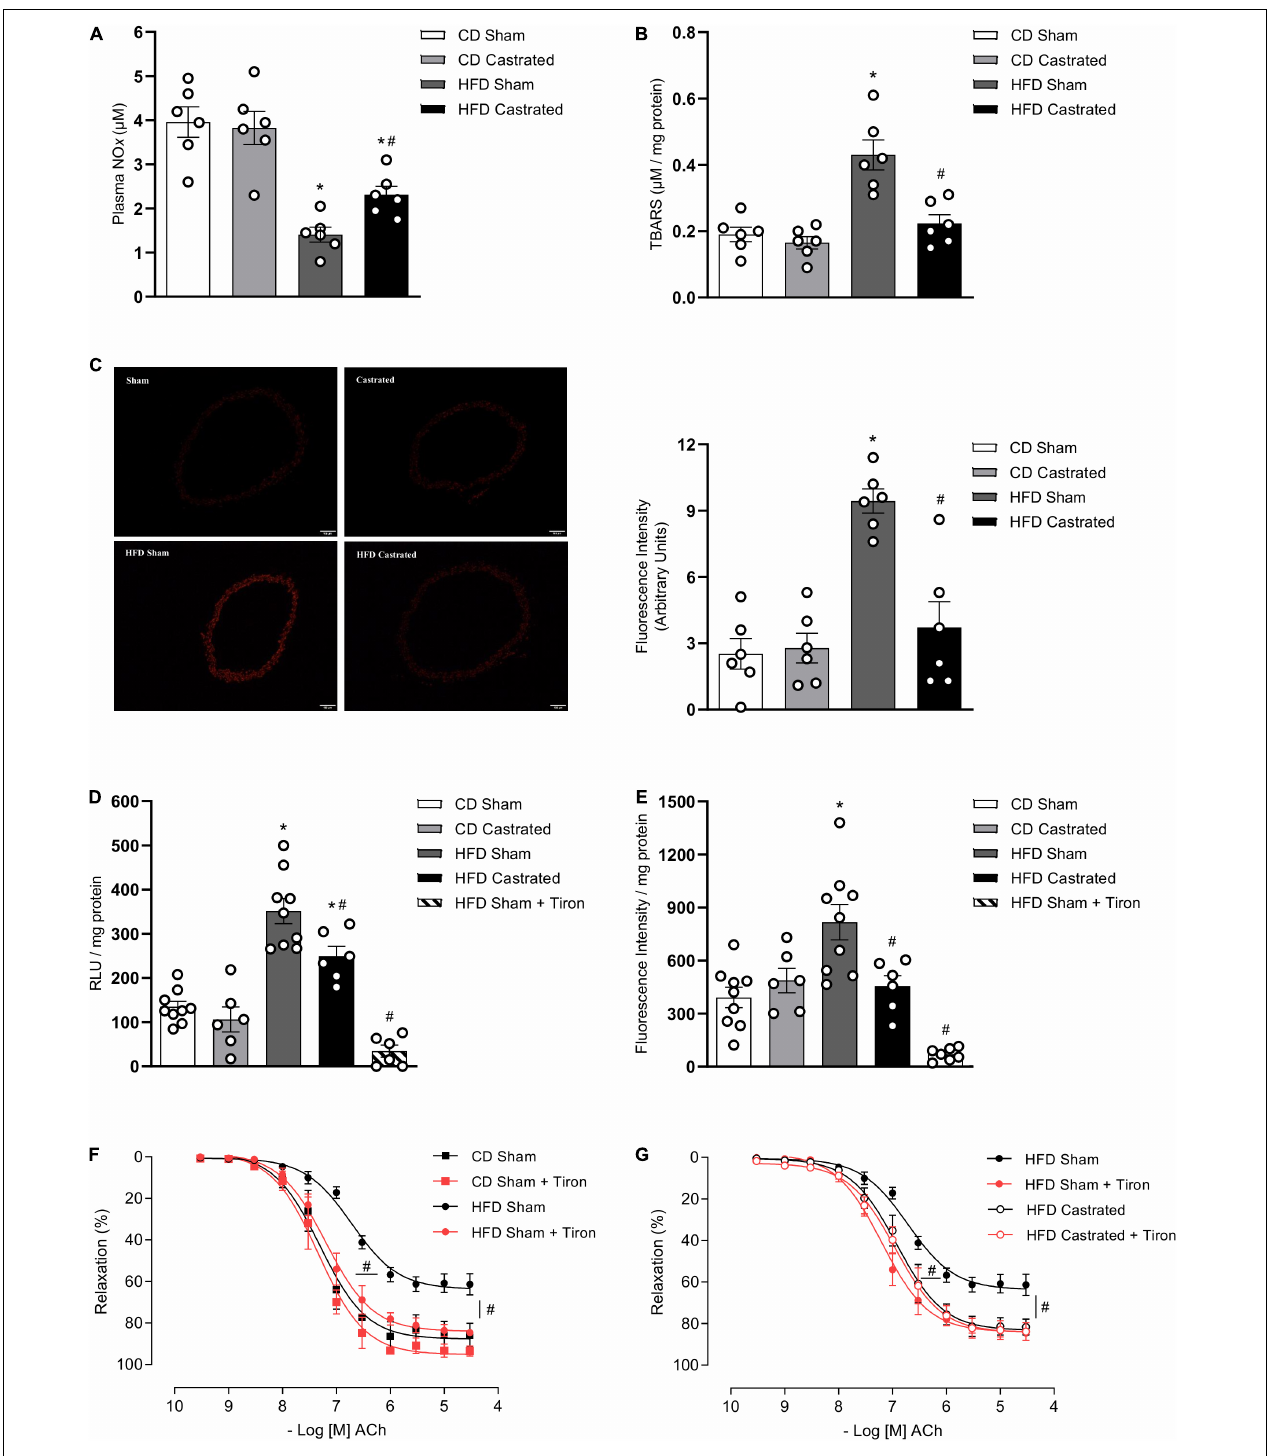
FIGURE 2 | Testosterone contributes to vascular oxidative stress in high fat diet (HFD)-fed mice. Plasma NO x [ (A) n = 6 for each experimental group], TBARS [ (B) n = 6 for each experimental group], reactive oxygen species generation – measured by DHE [ (C) n = 6 for each experimental group], superoxide anion generation – measured by lucigenin [ (D) n = 6 or 9 for each experimental group], and hydrogen peroxide levels – determined by amplex red [ (E) n = 6 or 9 for each experimental group] were evaluated in aortas isolated from mice of the different experimental groups. Concentration-response curves to acetylcholine (Ach) were performed in aortic rings isolated from control diet (CD) sham, HFD sham, and HFD castrated mice in the presence of Tiron (10 − 4 M) [ (F,G) n = 7 in all groups]. Data are expressed as mean ± SEM. * p < 0.05 vs . CD Sham; # p < 0.05 vs . HFD Sham.